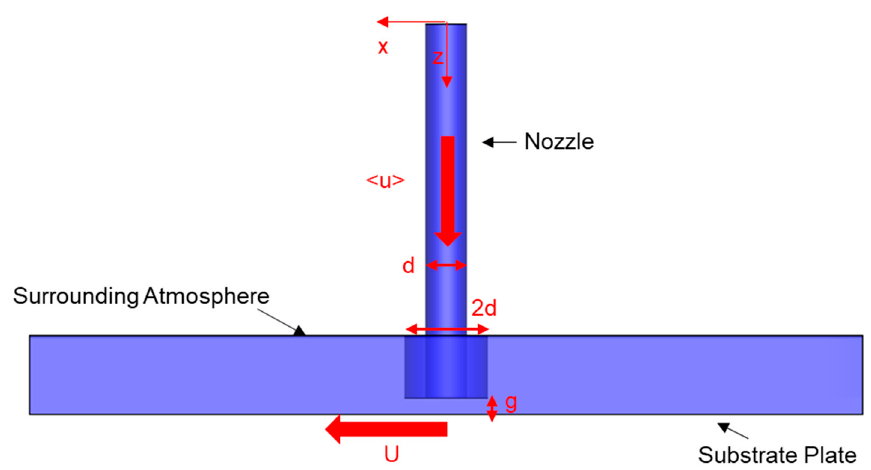
Figure 1. Schematic of the simulated system: nozzle and a substrate plate. The flow in the nozzle is in the z-direction. The substrate is moving in the x-direction.